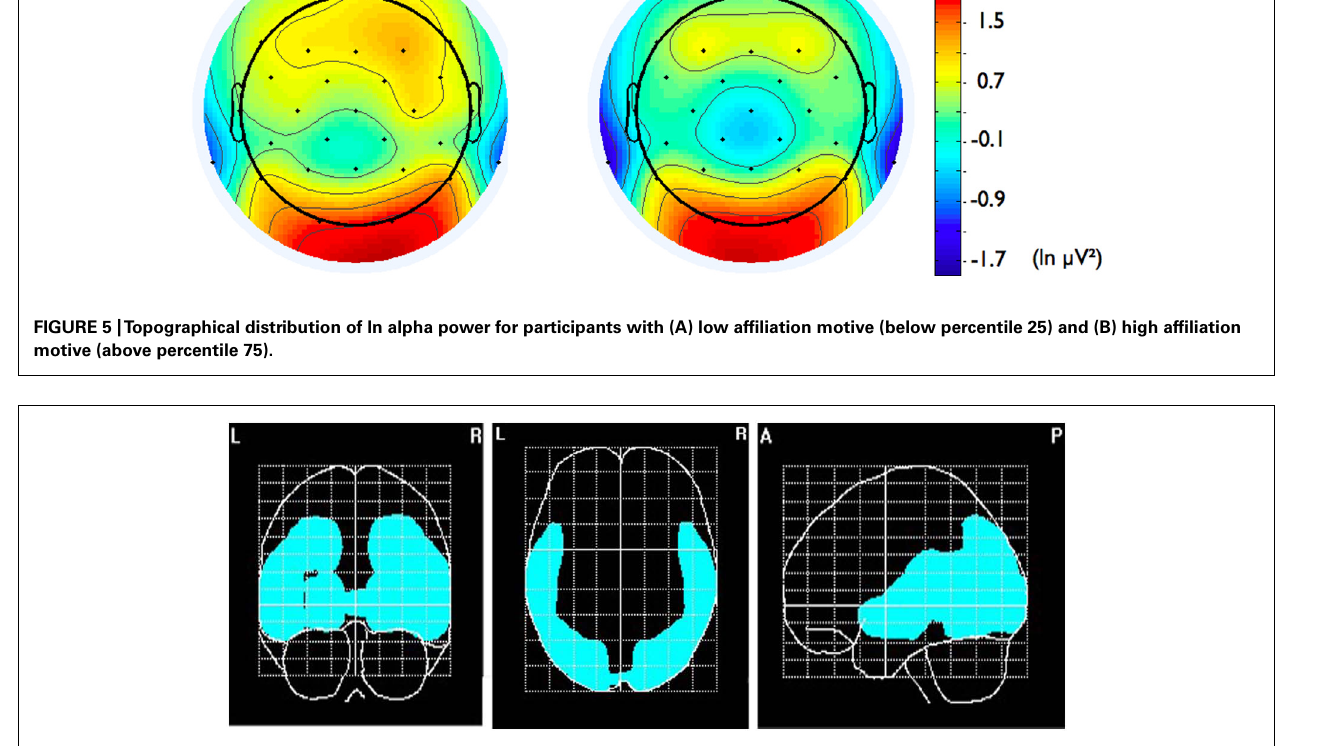
FIGURE 6 | Source localization of EEG alpha (8–13 Hz). N = 70; marked voxels indicate primary current density values for the alpha frequency spectrum 1 SD above the